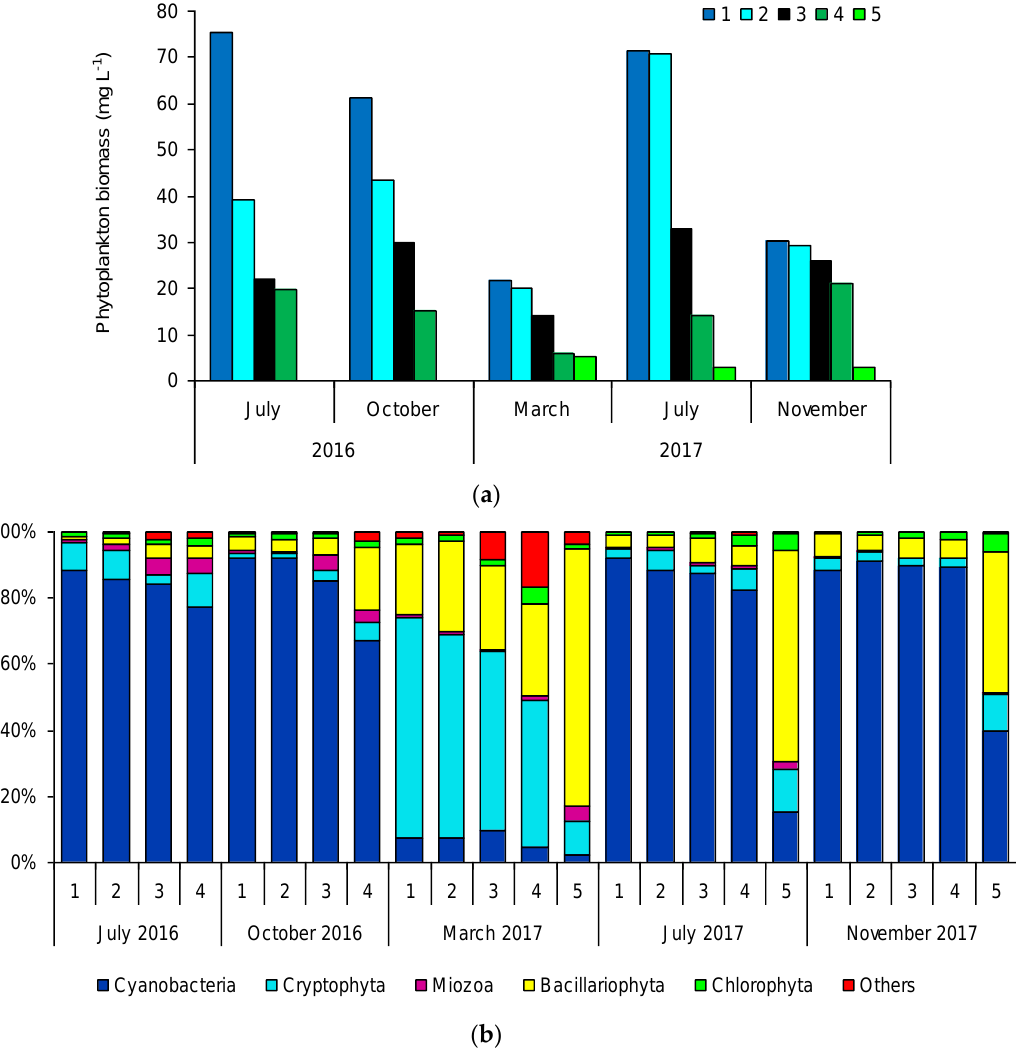
Figure 3. Temporal and spatial distribution of the total phytoplankton biomass ( a ) and composition ( b ); sites 1–4 in Lake Warnołty, site 5 in Lake Śniardwy.